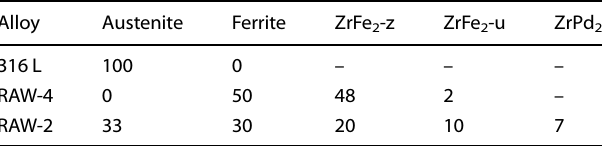
Table 3. Estimated area fraction amounts of the phases in the three alloys, %.